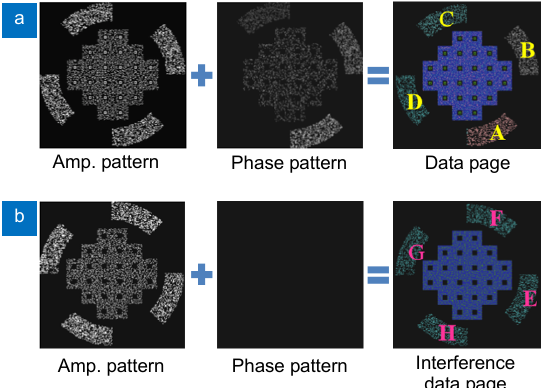
Fig. 6 | The complex amplitude data page and interference data page . ( a ) Data page. ( b ) Interference data page (IDP).